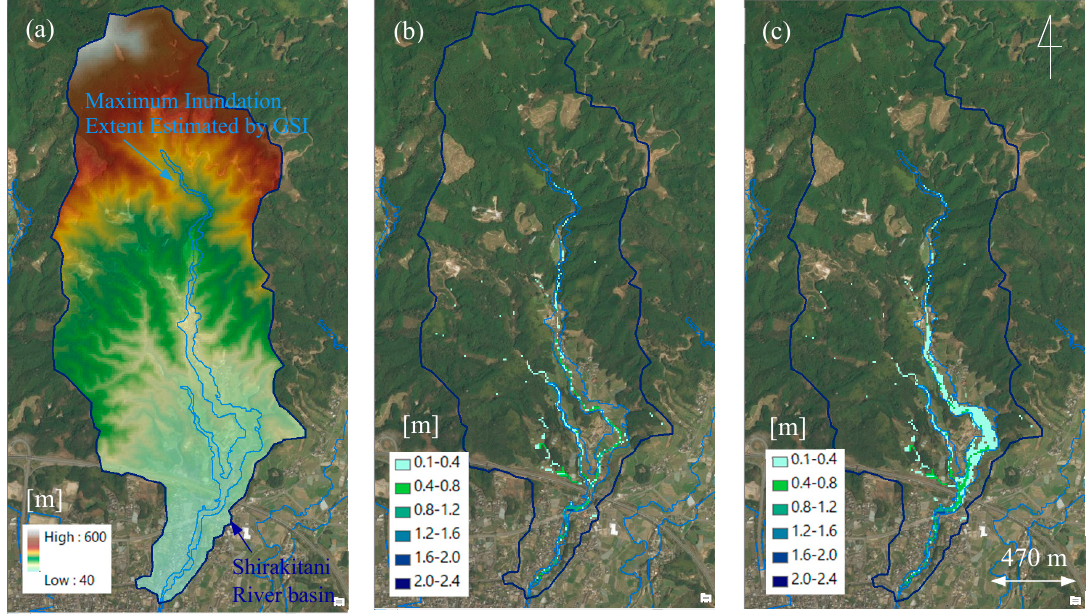
Figure 14. Same as the Figure 13, but with ( a ) original DEM and ( b ), ( c ) covering for the entire river basin.